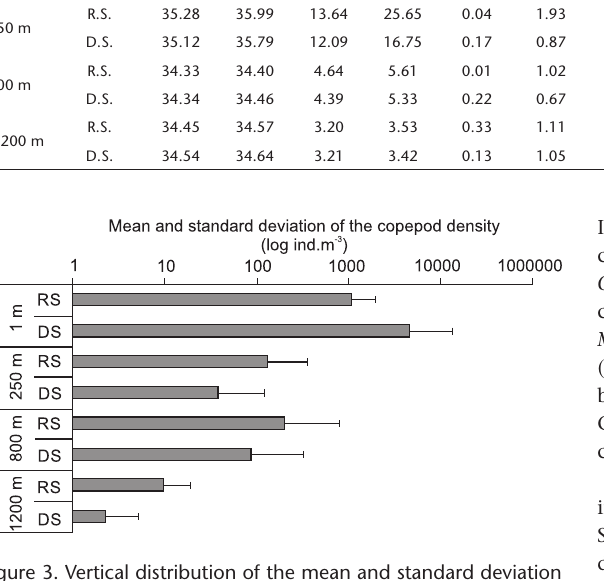
Figure 3. Vertical distribution of the mean and standard deviation of the copepod density (log ind.m - ³) during two sampling periods: rainy season, RS; dry season,